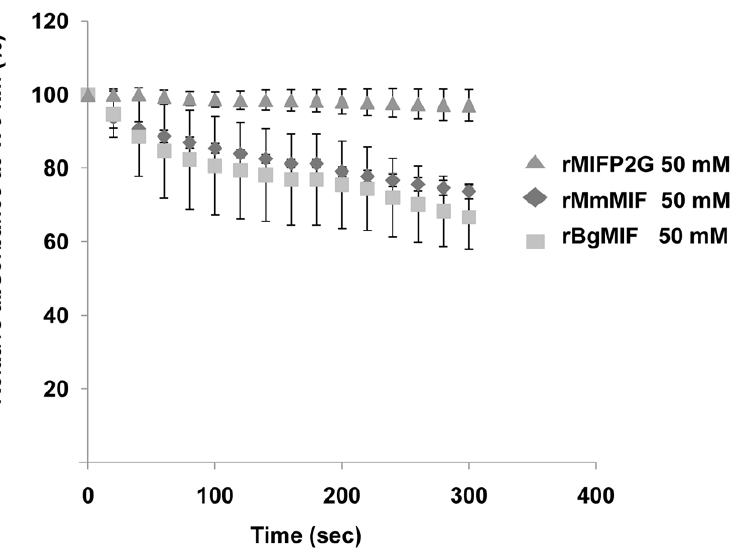
Figure 2. D-dopachrome tautomerase activity. Analysis of the D-dopachrome tautomerase enzymatic activity measured by loss in absorbance at 475 nm and plotted against the concentration of 2-carboxymethylester-2,3-dihydroindole-5,6-quinone for 50 nM wild type rBgMIF and mutated rBgMIF P2G. MmMIF at the same concentration was used as a positive control. Results shown are the means + / 2 S.D. of three independent